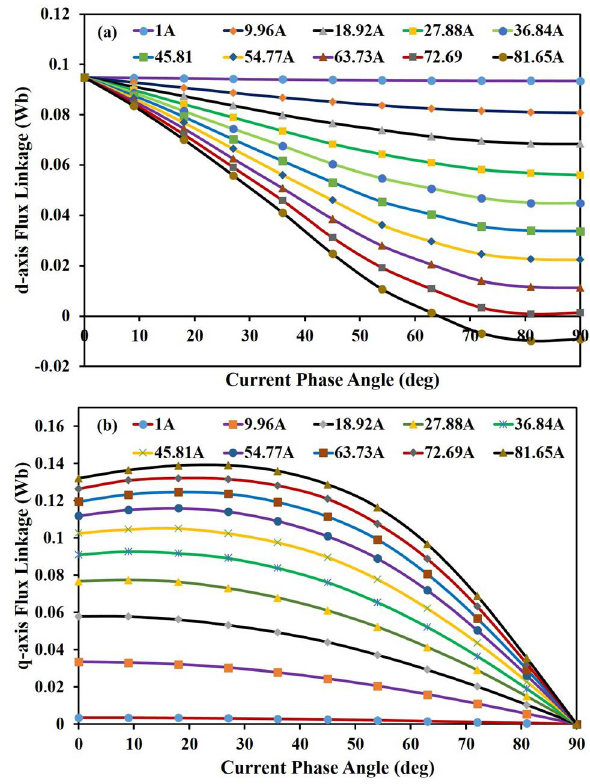
Figure 8. Flux linkage variations on ( a ) d- and ( b ) q- axis of IPMSM with respect to current and current angle.